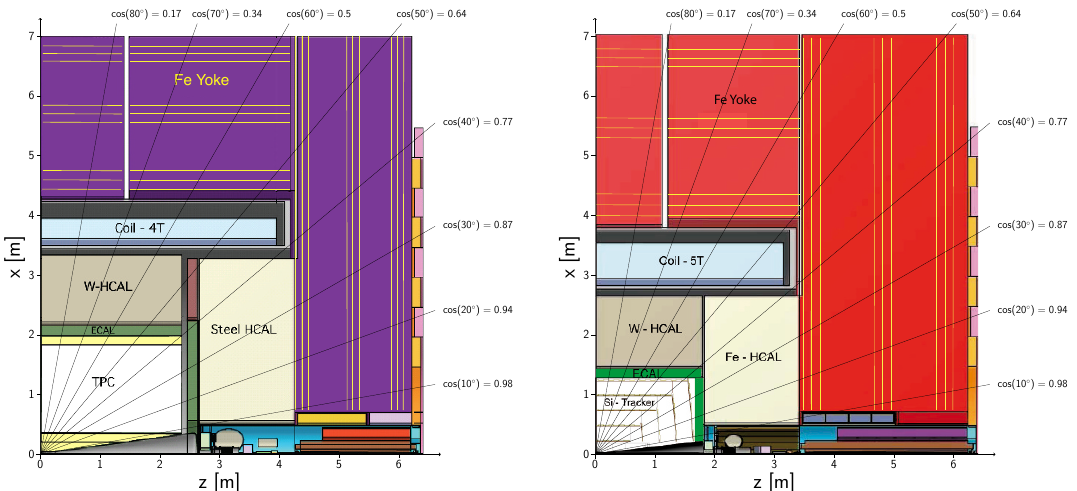
Figure 2. Longitudinal cross section of the top right quadrant of the CLIC ILD (left) and CLIC SiD (right) detector concepts